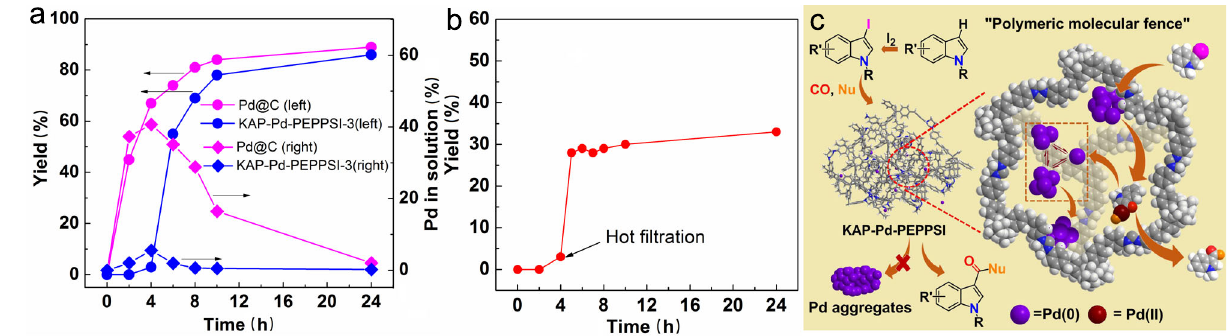
Fig. 5 Reaction process investigation. a Kinetic investigation. b Hot fi ltration test. Under the optimized reaction conditions, the reaction mixture was quickly divided into two parts by centrifugation after reaction for 4 h, and the upper clear liquid proceeded to react for another 20 h in the presence of CsF. c Stabilizing effect of the hypercrosslinked polymer on active Pd species in KAP-Pd-PEPPSI catalyzed fl uorocarbonylation of indole.